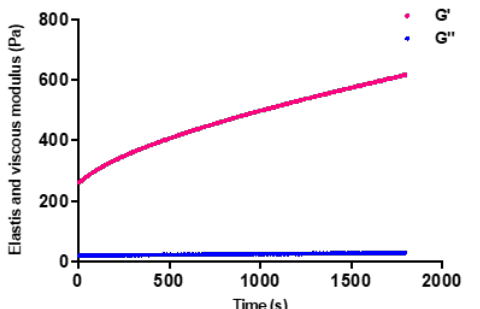
Figure 5. Elastic and viscous modulus changes versus time with a constant temperature at 37 °C for of CI:CS sol.